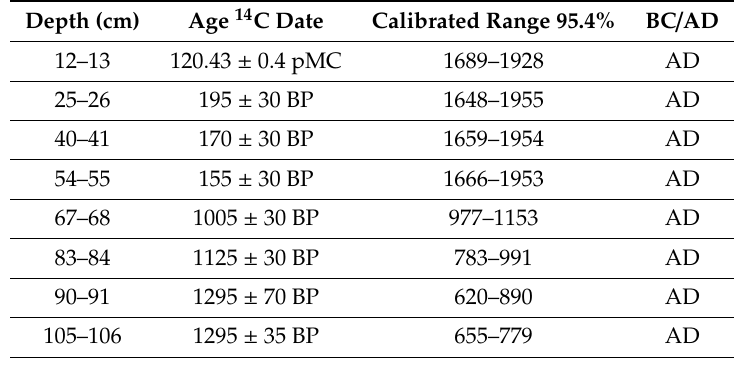
(Table 4). Moisture contents of peat samples ranged from 93.15% to 93.92% (Table 5). Table 4. The radiocarbon 14 C dates for fen St ˛a˙zka.